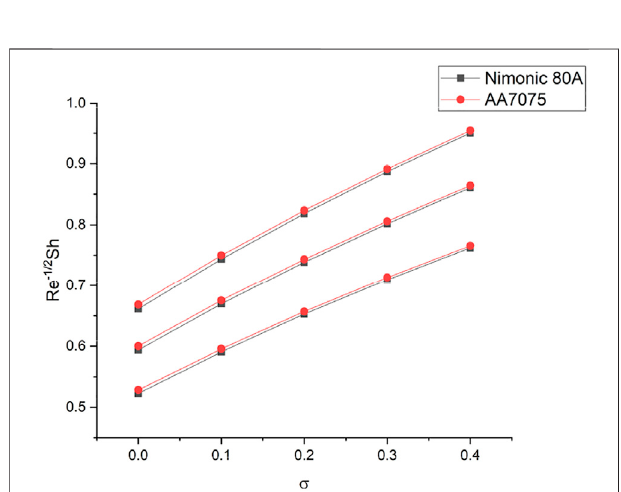
FIGURE 10 | Change in Re − 1/2 Nu for Γ 1 versus A p .